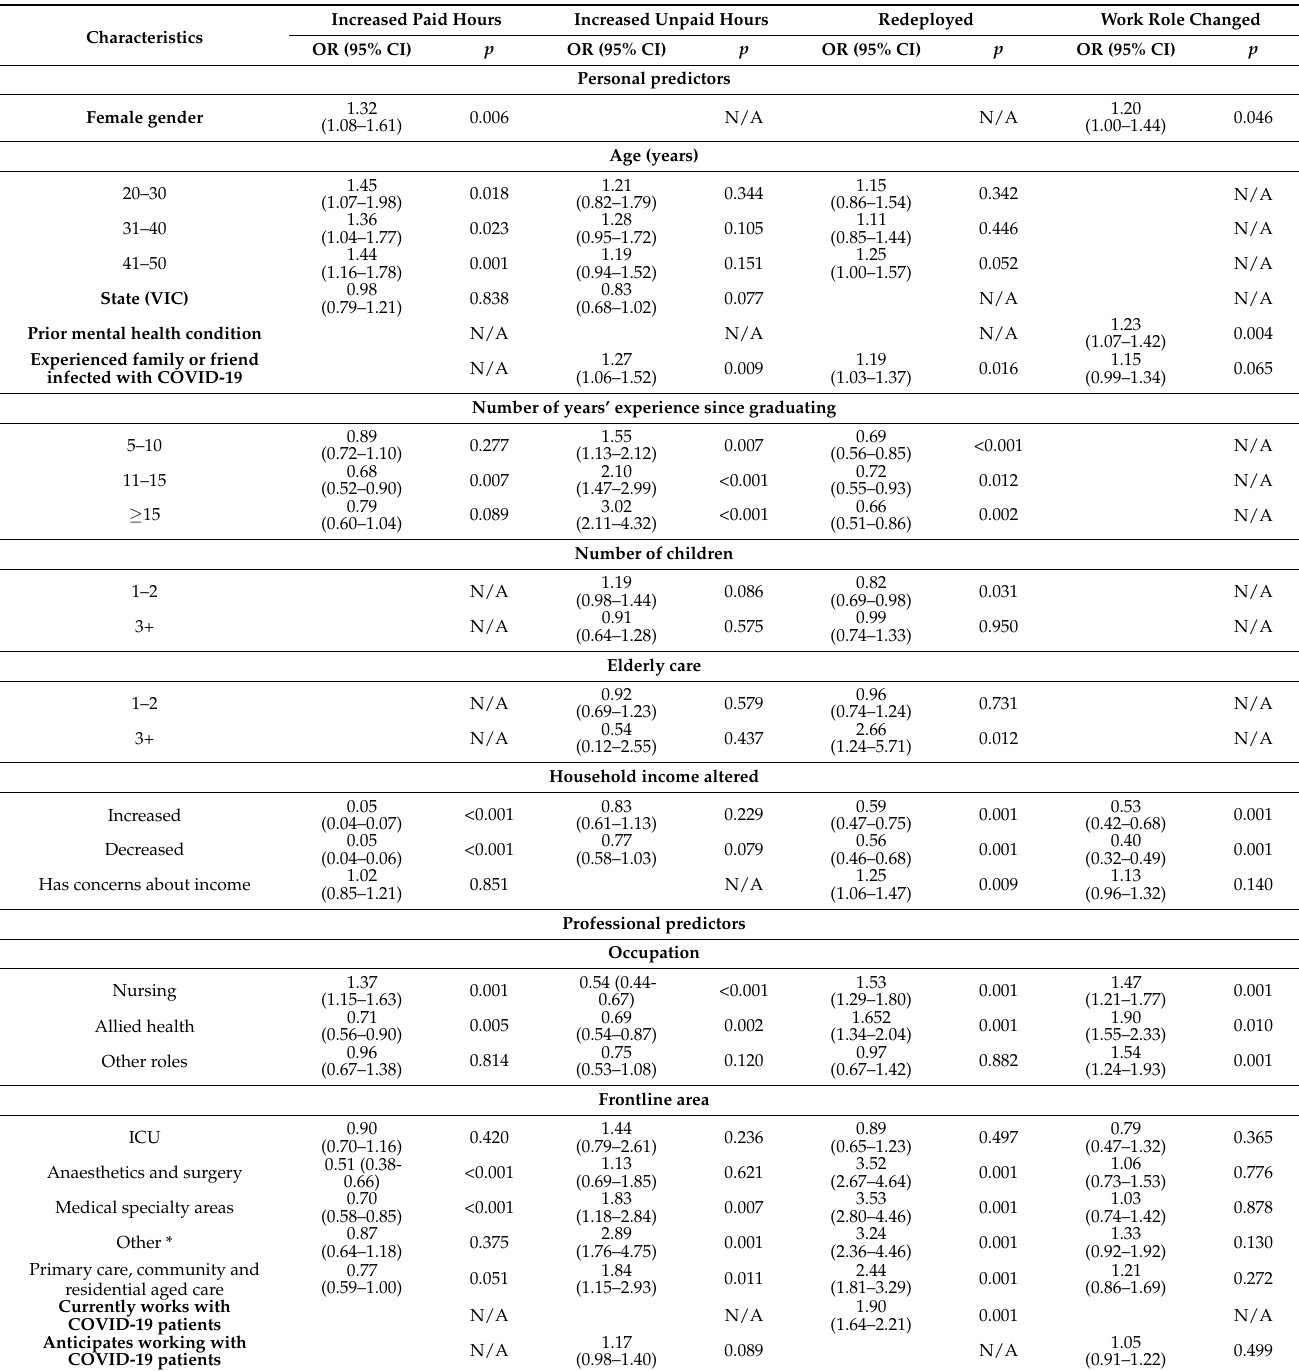
Table 3. Predictors of occupational